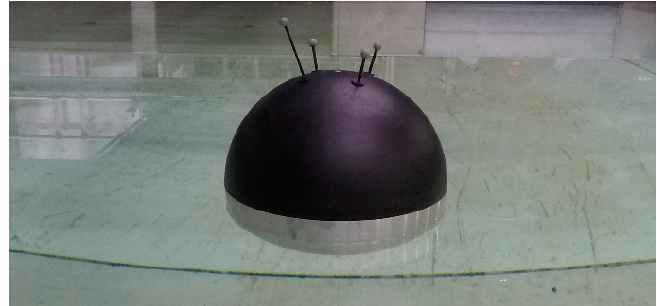
Figure 1. The sphere model used in the heave decay